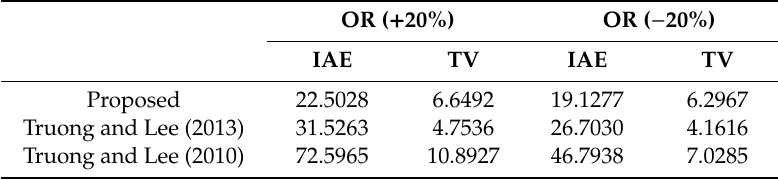
Table 10. Robustness analysis for the OR column under ±20% parametric uncertainties in all parameters.